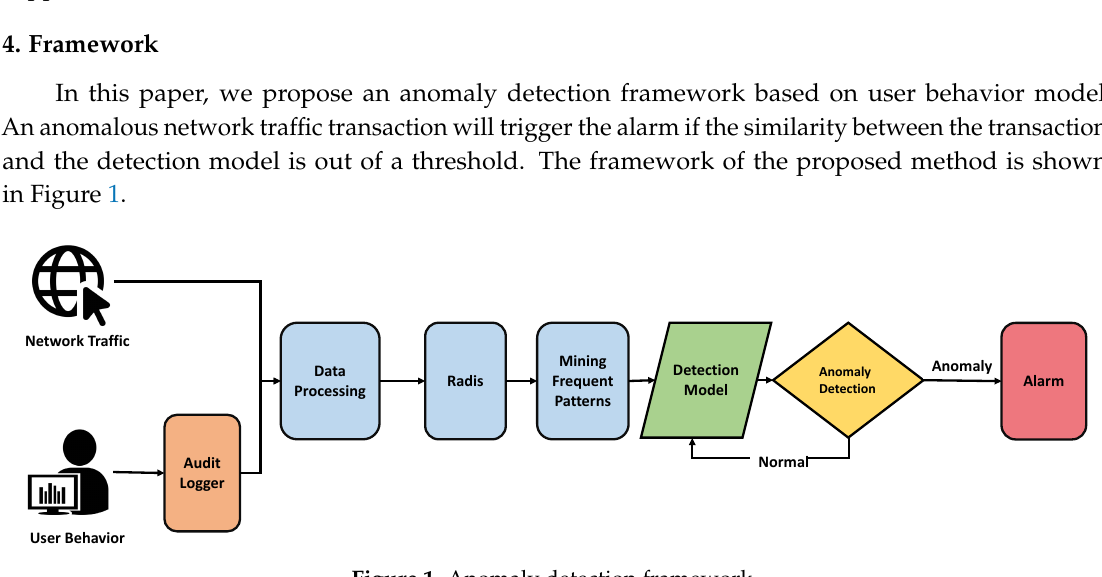
Figure 1. Anomaly detection